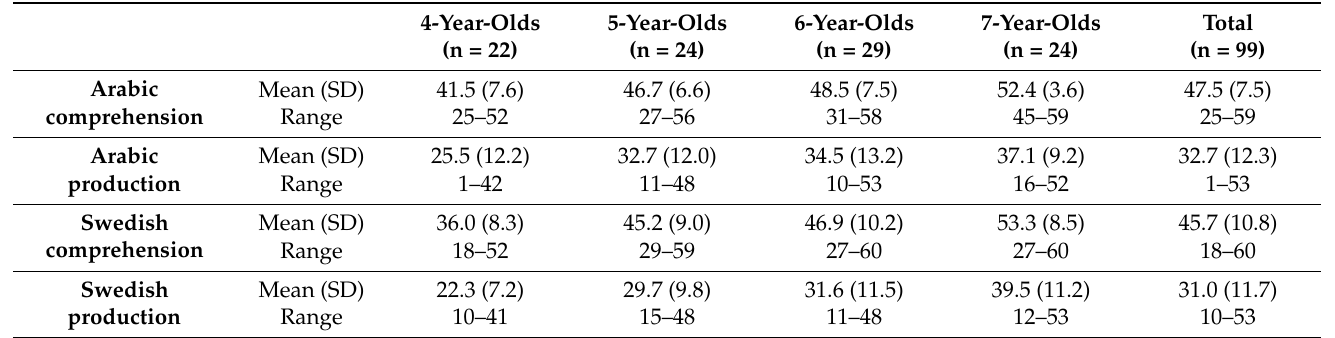
Table 3. Means, standard deviations (SD), and ranges for each CLT vocabulary task by age groups and total scores. Maximum score for all tasks = 60 points.